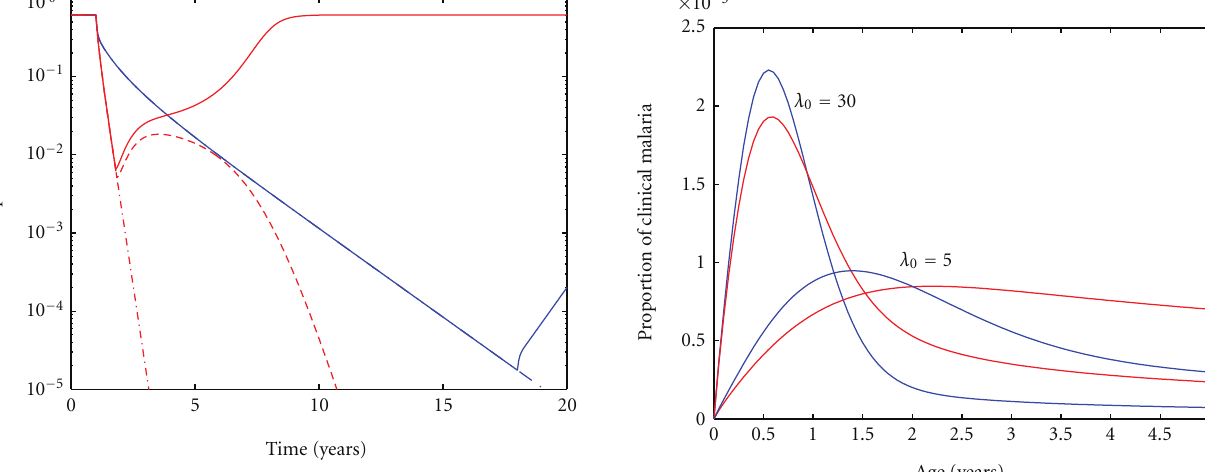
Figure 4: Age profiles for two transmission settings. Clinical P. vivax malaria age profiles (blue lines) compared with P. falciparum profiles (red lines) for equal risks of